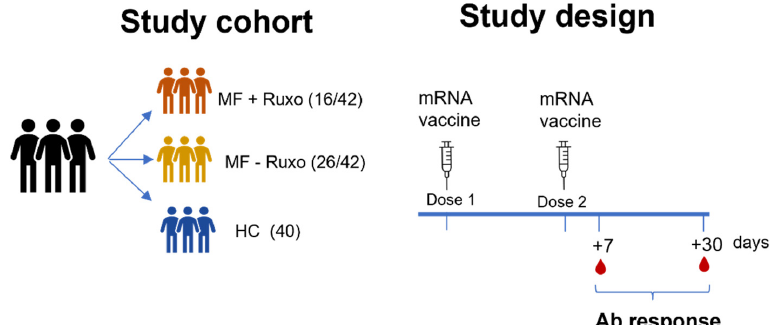
Figure 1. Schematic representation of the study cohort and design. Myelofibrosis (MF) patients treated or not with ruxolitinib (MF + ruxo or MF-ruxo) and healthy controls (HC) were immunized with two doses of mRNA vaccine anti SARS-CoV-2. Antibody (Ab) response was assessed 7 and 30 days after the second vaccine dose. Seven days after the booster dose, the geometric mean tire (GMT) of anti-spike specific IgG in MF patients was significantly lower compared to HC, regardless of ruxolitinib treatment (GMT of 20180, 1470 and 1060 in HC, MF-Ruxo and MF + Ruxo, respectively; p < 0.001; Figure 2A). Nevertheless, 30 days after the second dose, anti- spike IgG increased significantly in MF patients, reaching antibody titers similar to the ones observed in HC, especially in the group without ruxolitinib treatment (GMT of 7896, 6267 and 2436 in HC, MF-Ruxo, MF + Ruxo, respectively; Figure 2A,B). When MF patients were analyzed according to the ruxolitinib treatment, the 68% of treated and 81% of untreated patients developed a spike-specific plasma IgG response, showing a slightly lower response in ruxolitinib-treated subjects. While the spike-specific IgG titers in HC were slightly declining a month after the booster dose (Figure 2B), as recently reported [14–17], the antibodies elicited in MF patients were still increasing, thus showing a different kinetic of the secondary response,